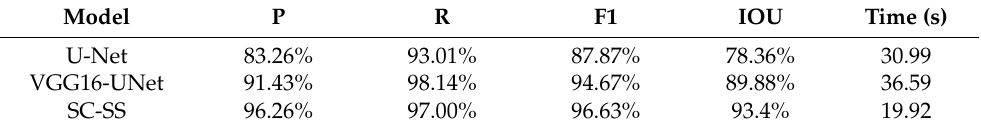
Table 3. Comparison of three models’ evaluation metrics on the large scene remote sensing image.